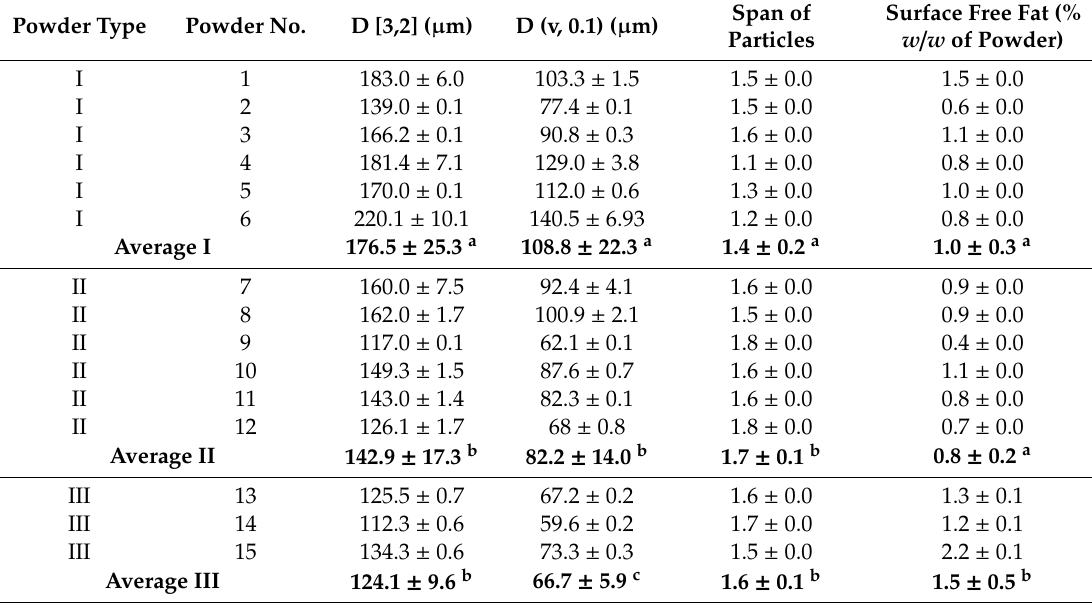
Table 3. Powder particle size and surface free fat for individual powders (mean of two replicates). Average values presented below were calculated based on powder type ± standard deviation.